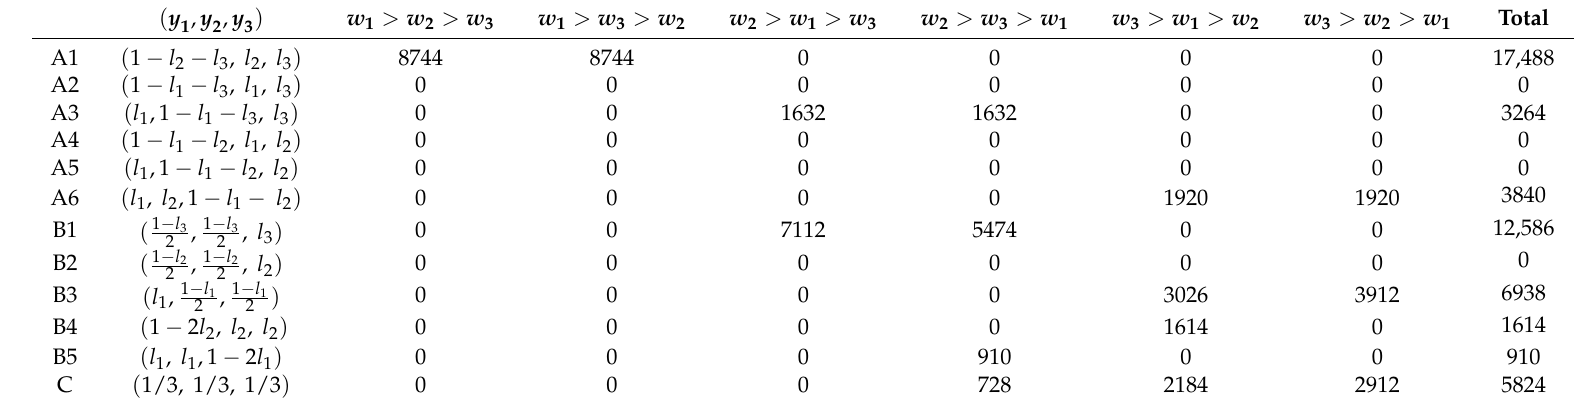
Table 3. The number of instances satisfying solution type and weight for 3COWAL with − 1 ≤ l 3 < l 2 < l 1 ≤ 1.